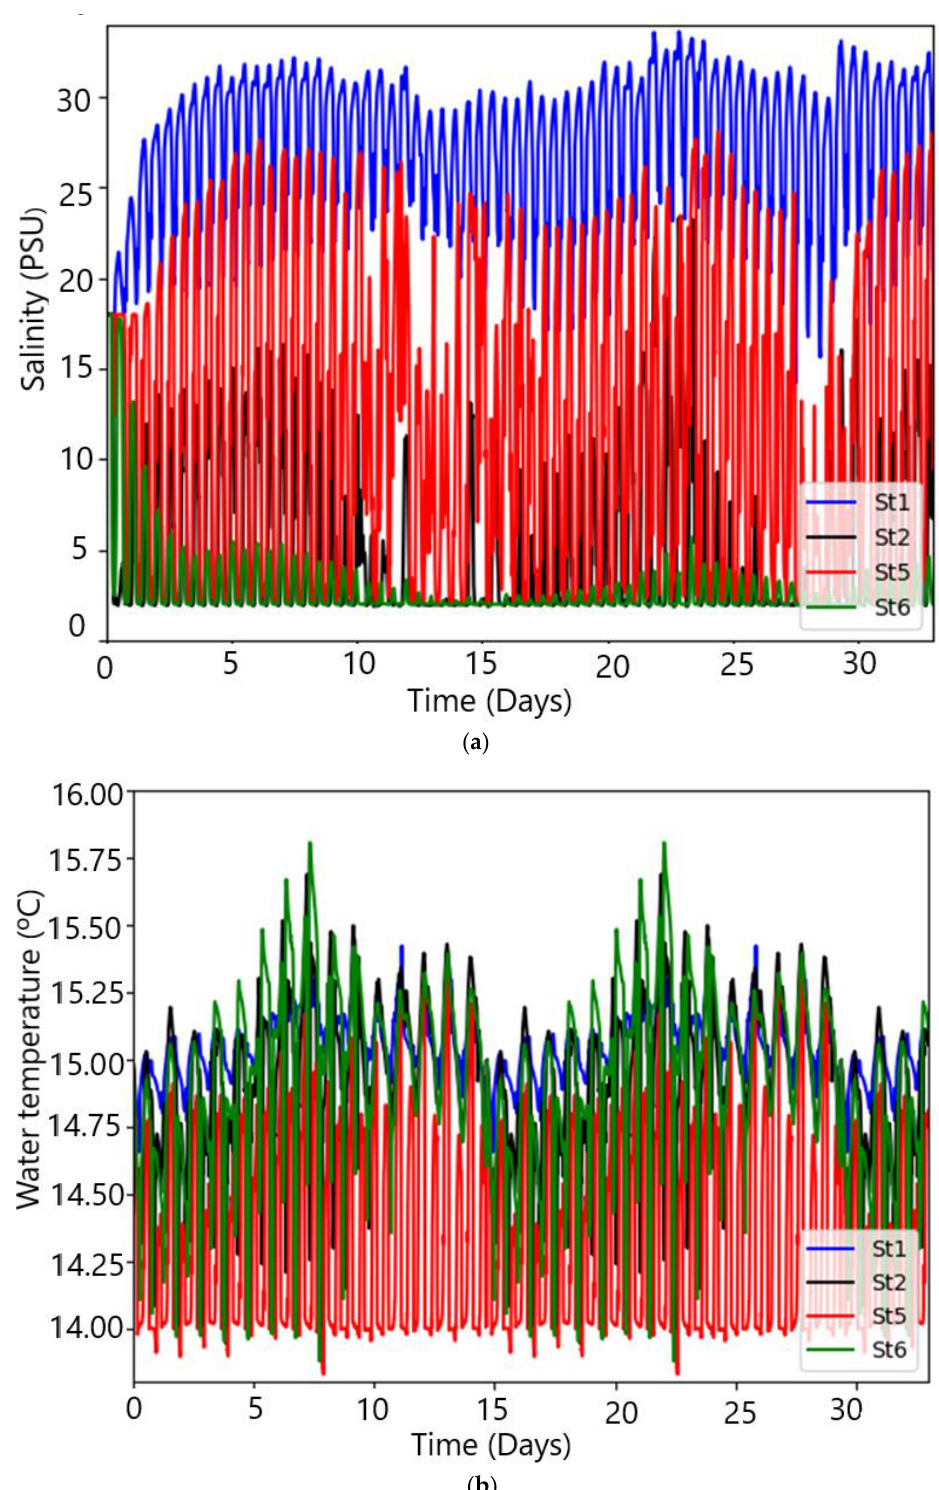
Figure 4. ( a ) Simulated salinity for March 2001, for St1, St2, St5, and St6. ( b ) Simulated water temperature for March 2001, for St1, St2, St5, and St6.